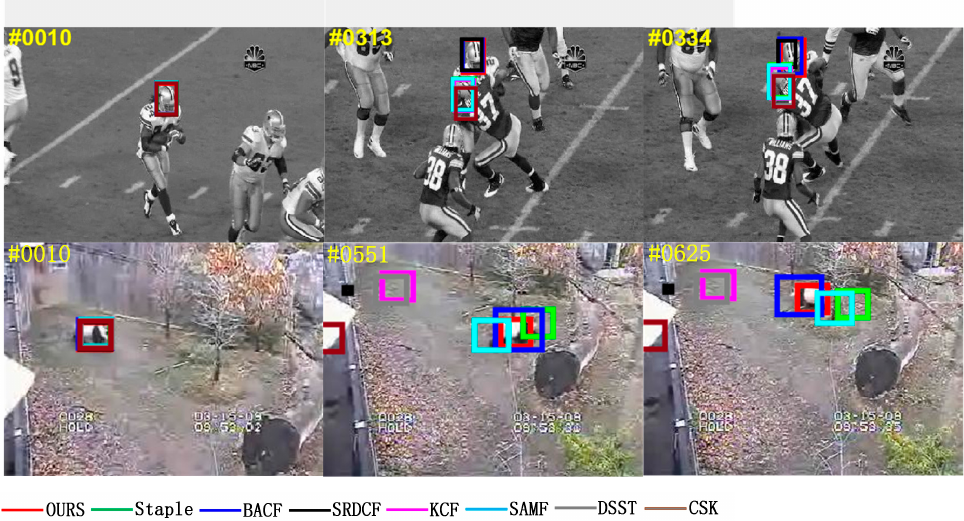
Figure 11. Visual comparison with eight trackers in the “Football_1” and “Panda_1” video sequences in an occlusion challenge scenario.